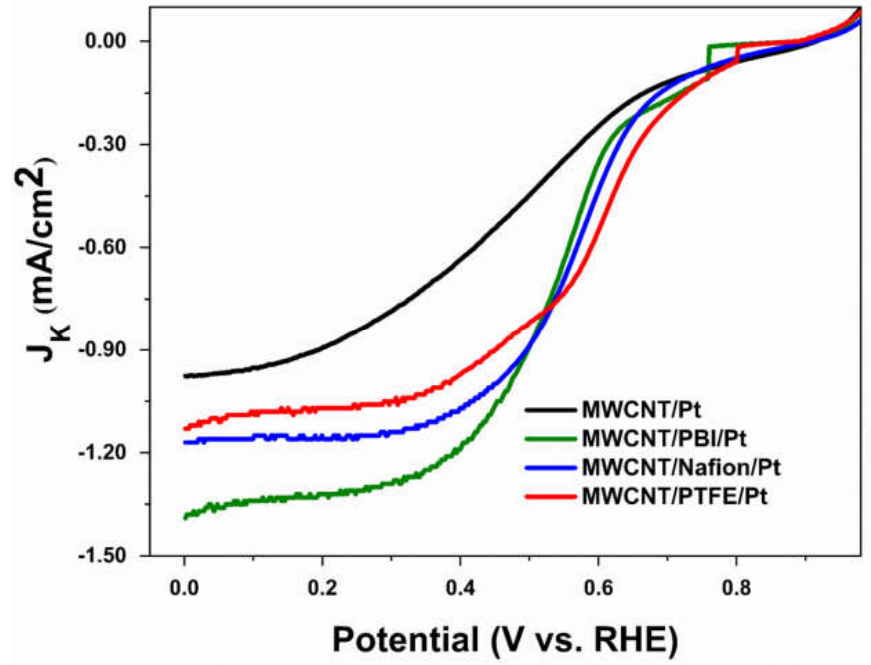
Figure 9. The linear sweep voltammetry curves of all electrodes in oxygen gas saturated 1.0 M H 2 SO 4 using a 10 mV/s scan rate and a rotation rate at 1200 rpm.